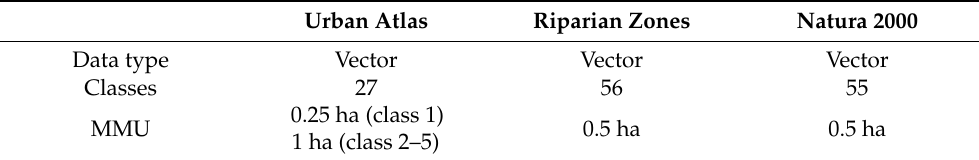
Table 2. Copernicus Land Monitoring Service—local component data.